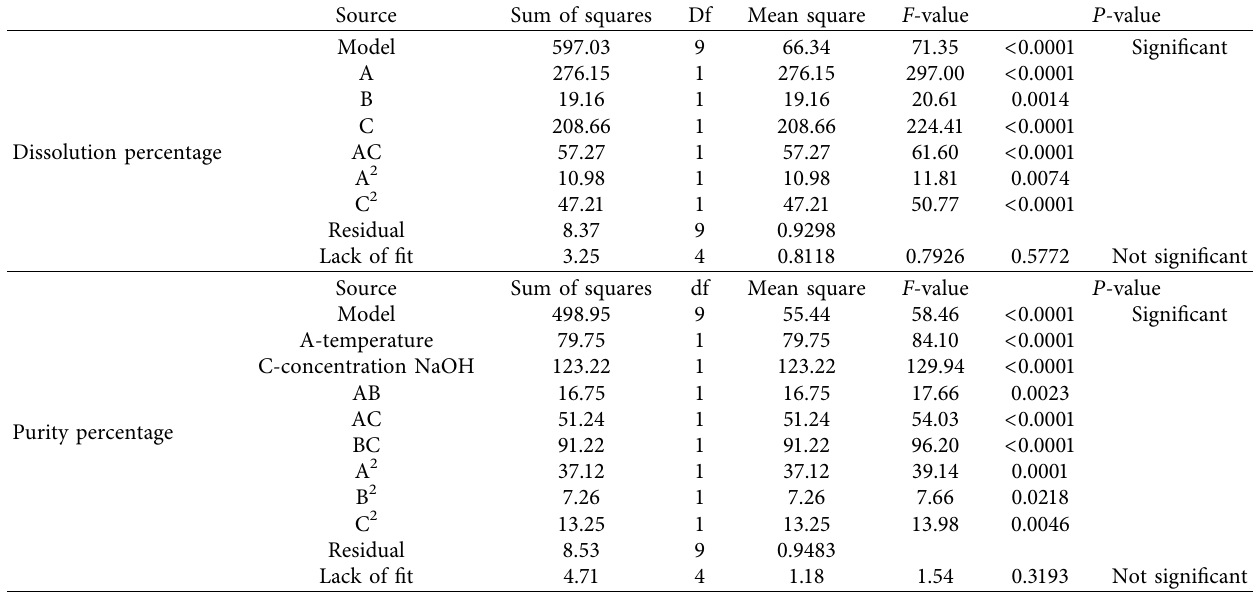
Table 4: Analysis of variance (ANOVA) for dissolution and purity percentage of keratin.